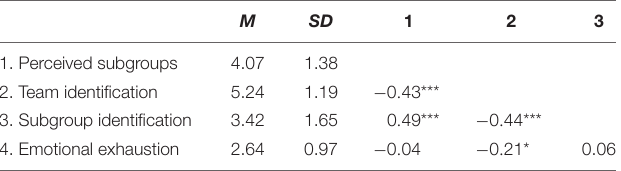
TABLE 1 | Means, Standard Deviations, and Zero-Order Correlations of Variables (participant-level).